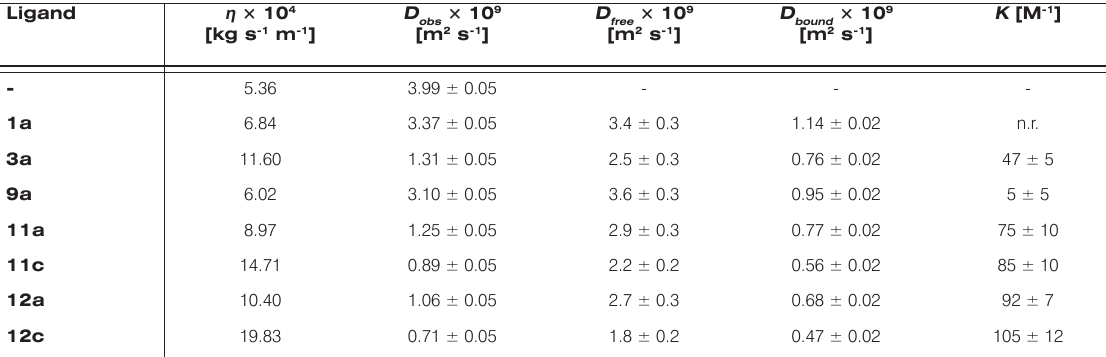
Table 3. Results of 129 Xe NMR diffusiometric measurements of complexation process. Ligand η × 10 4 [kg s -1 m -1